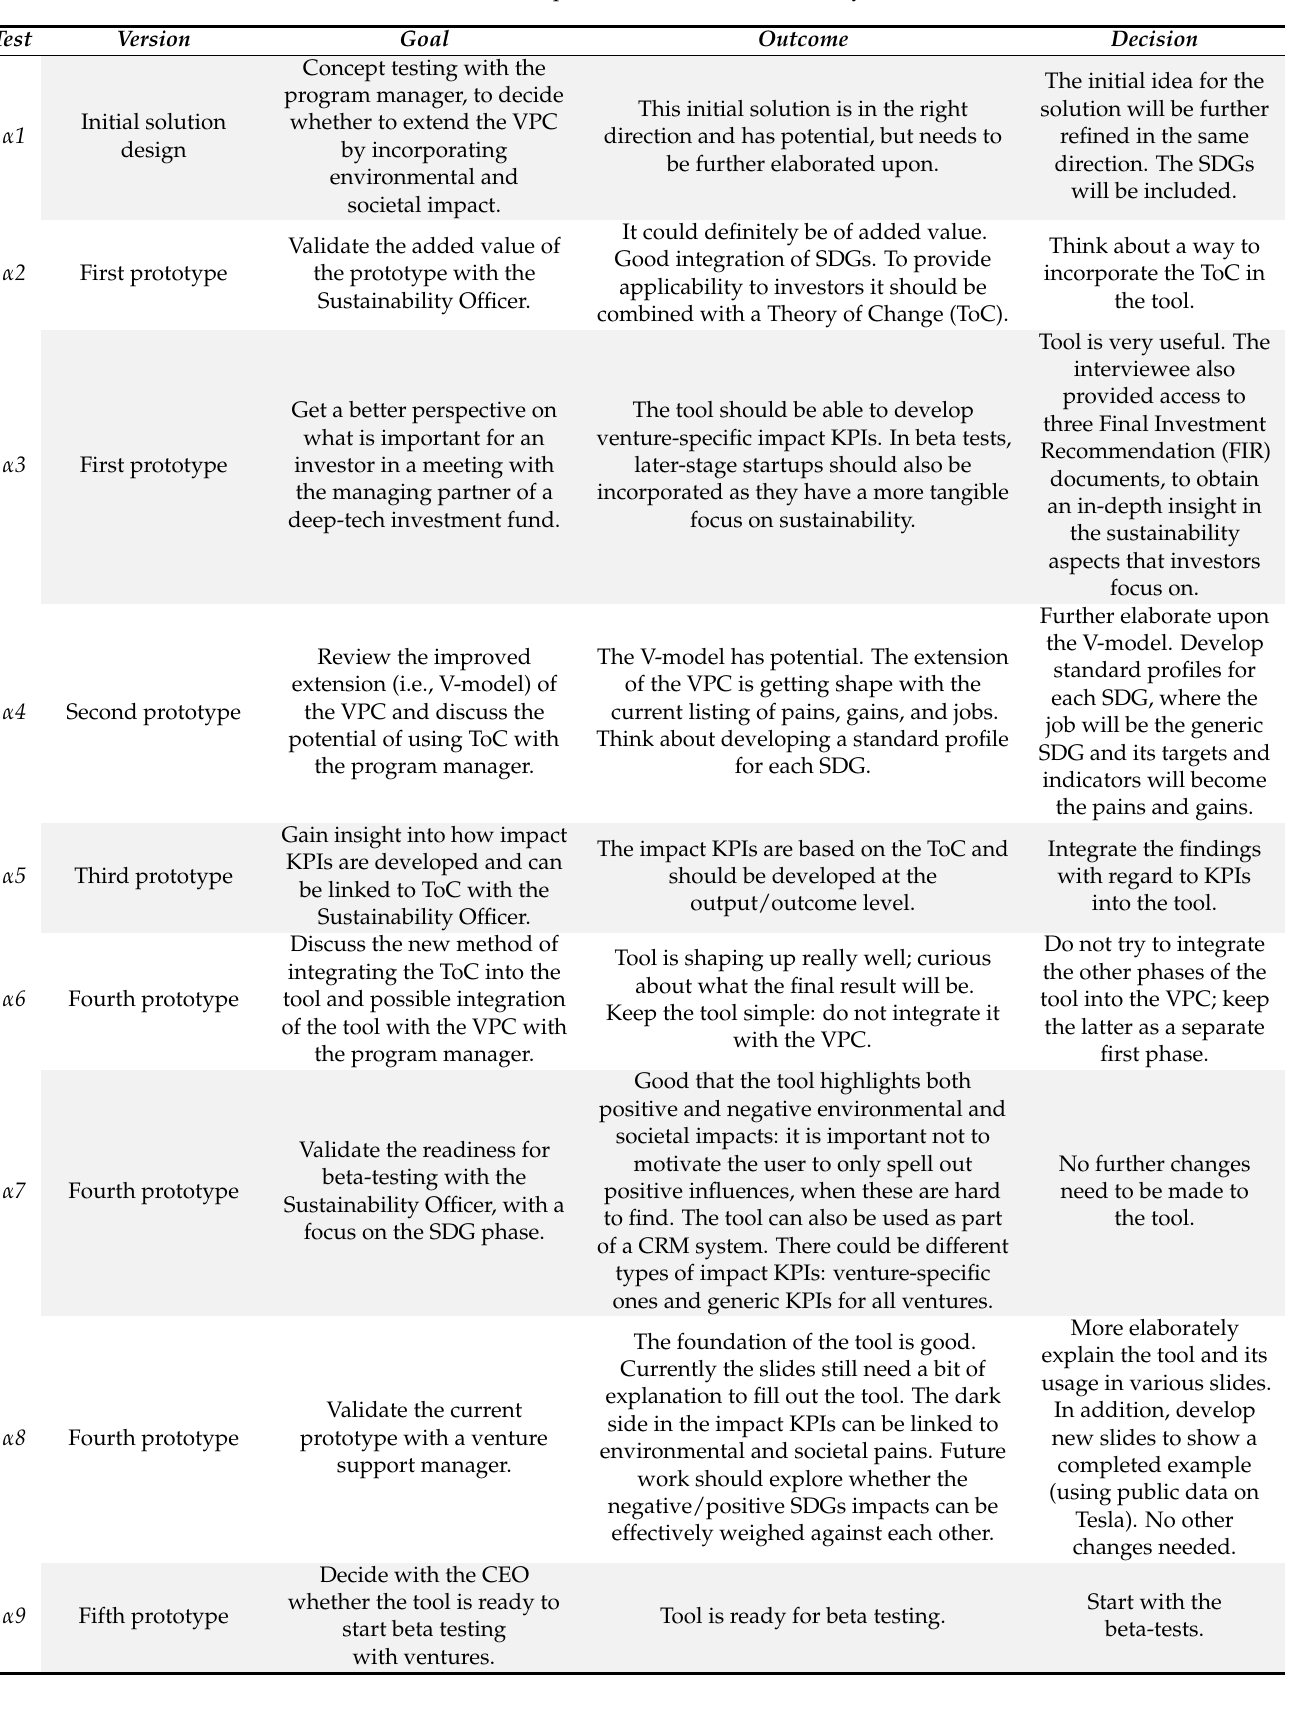
Table A2. Overview of alpha-tests (conducted from May to November